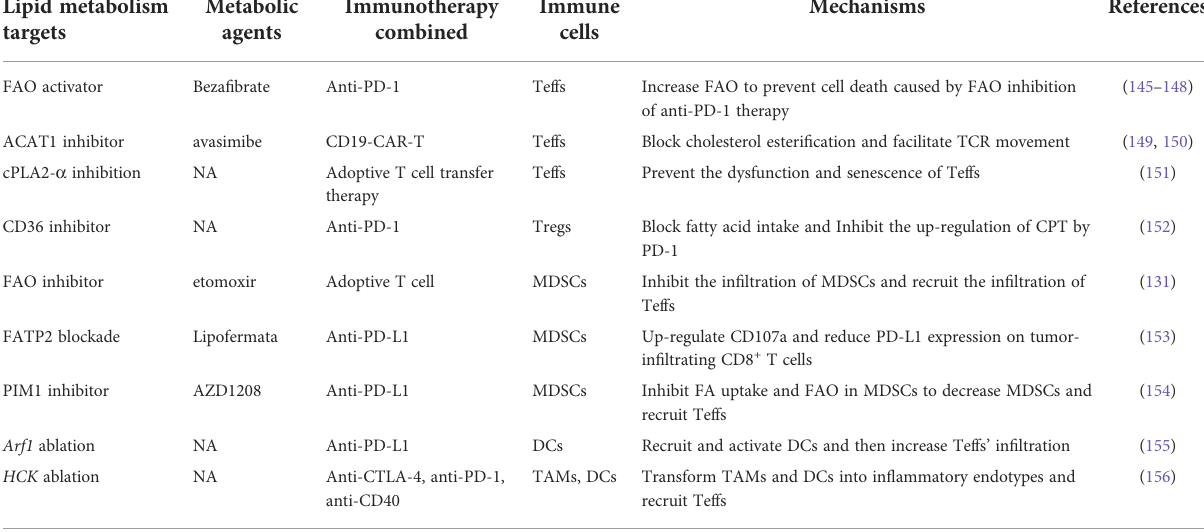
TABLE 1 The combination of lipid metabolism targeted therapy and immunotherapy. Lipid metabolism